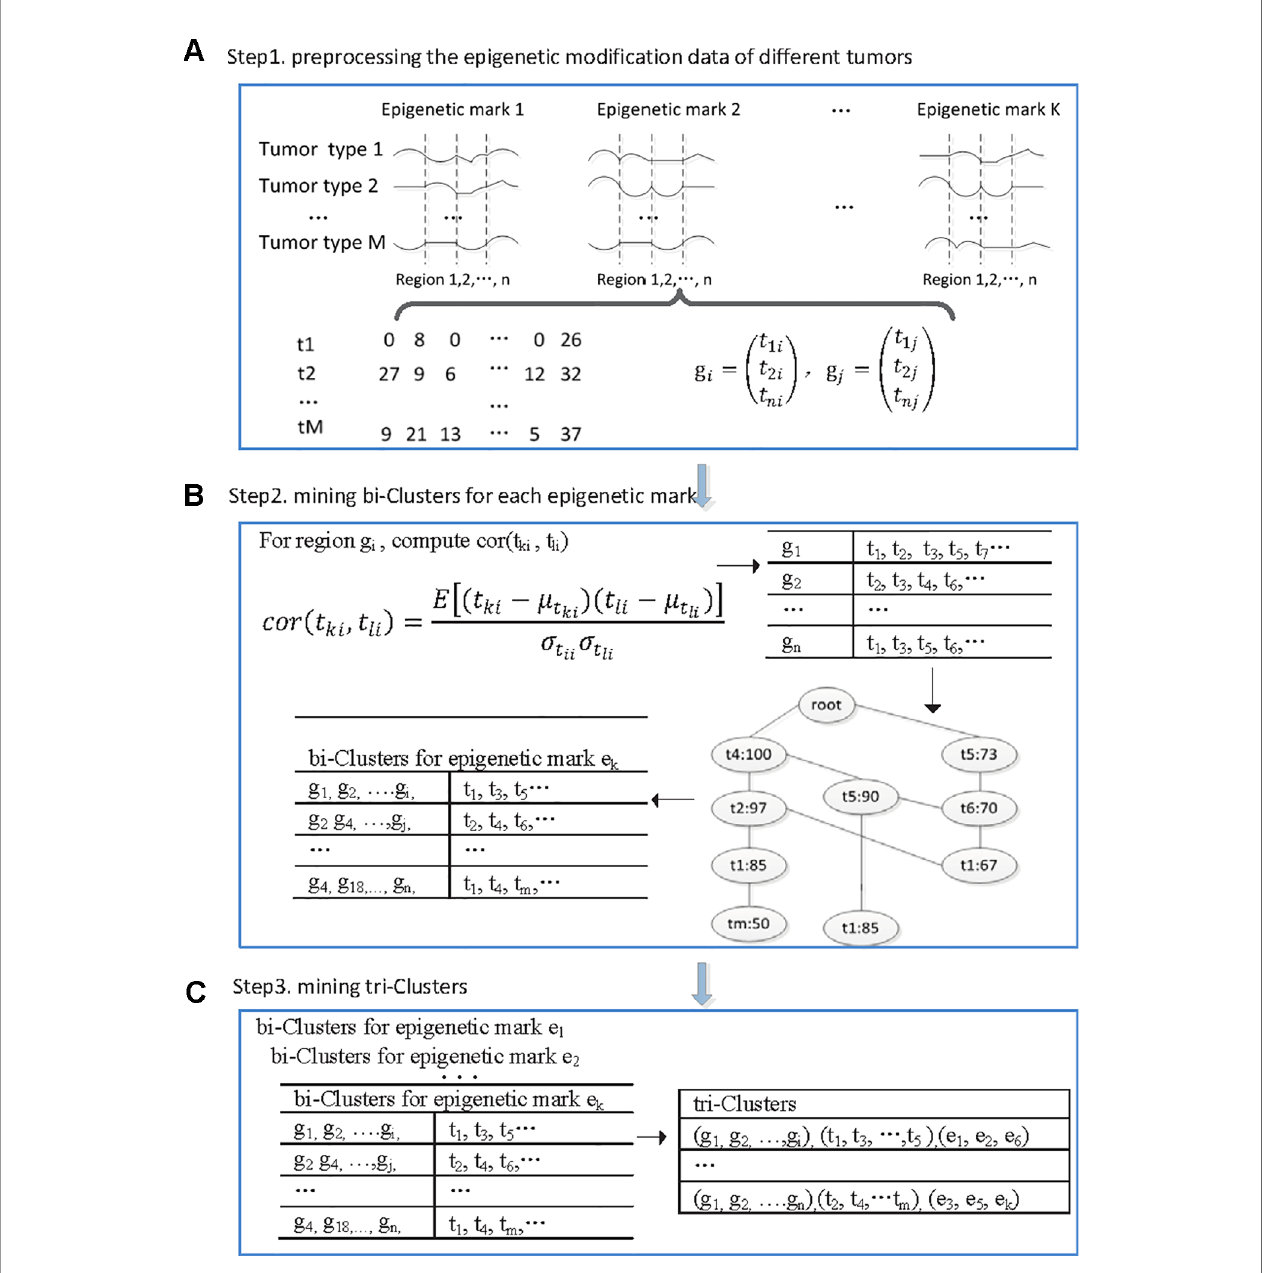
FIGURE 1 | The fl owchart of the proposed TriPCE approach. (A) Preprocessing the epigenetic modi fi cation data of different cancer types. (B) For each epigenetic mark, identifying bi-Clusters based on the FP-growth algorithm. (C) Mining tri-Clusters with coherent epigenetic modi fi cation patterns across different cancer